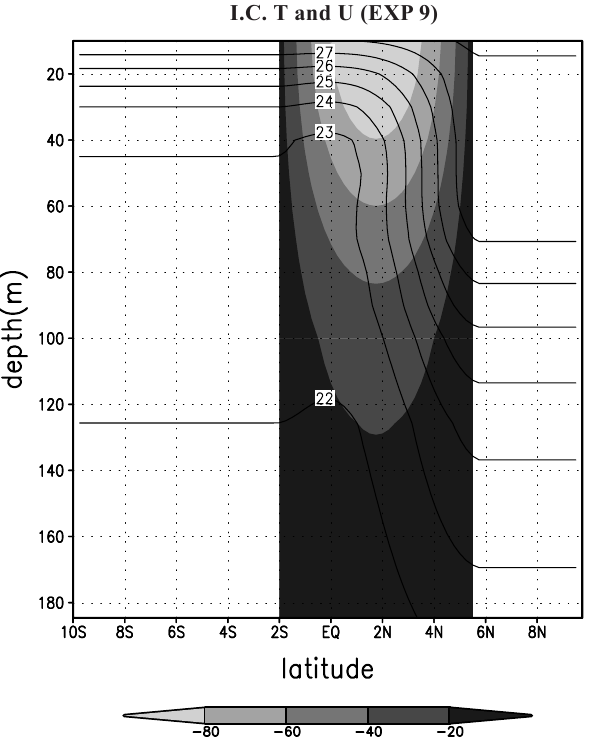
Fig. 7. Time-latitude diagram of perturbation meridional velocity at 5m for EXP 9. Contour interval is